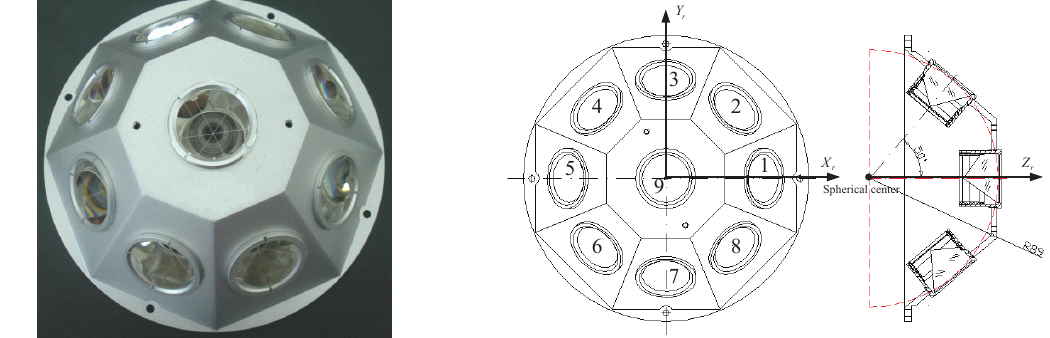
Figure 9. Left is the LRA configuration for TG02. Right is the structural profile of LRA for TG02.